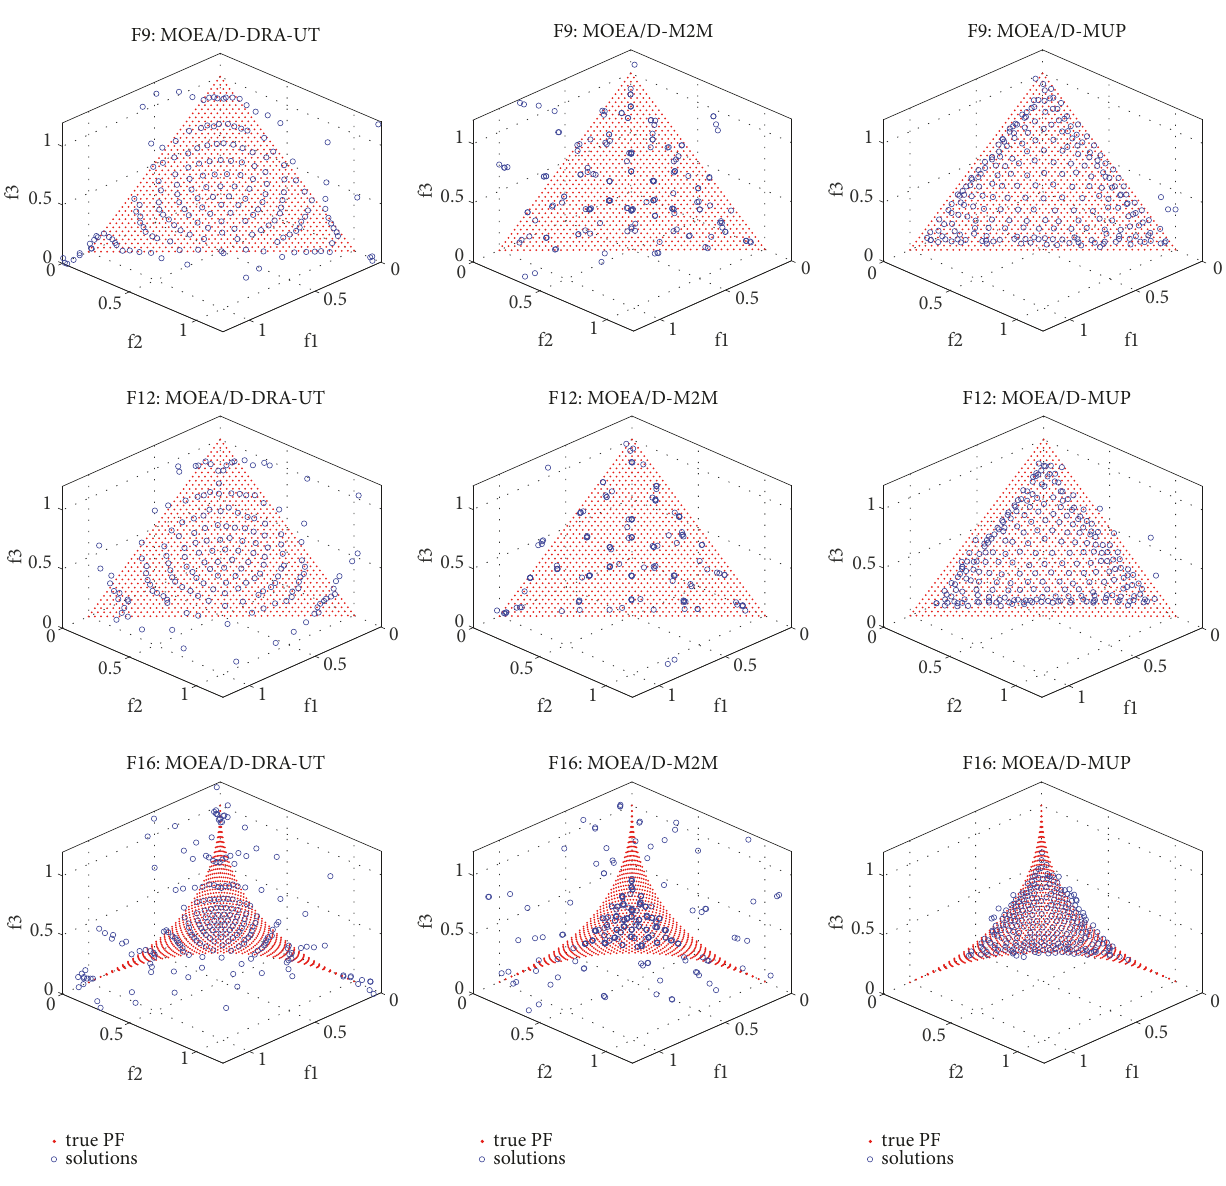
Figure 9: The final populations obtained by MOEA/D-DRA-UT, MOEA/D-M2M, and MOEA/D-MUP on F9, F12, and F16.